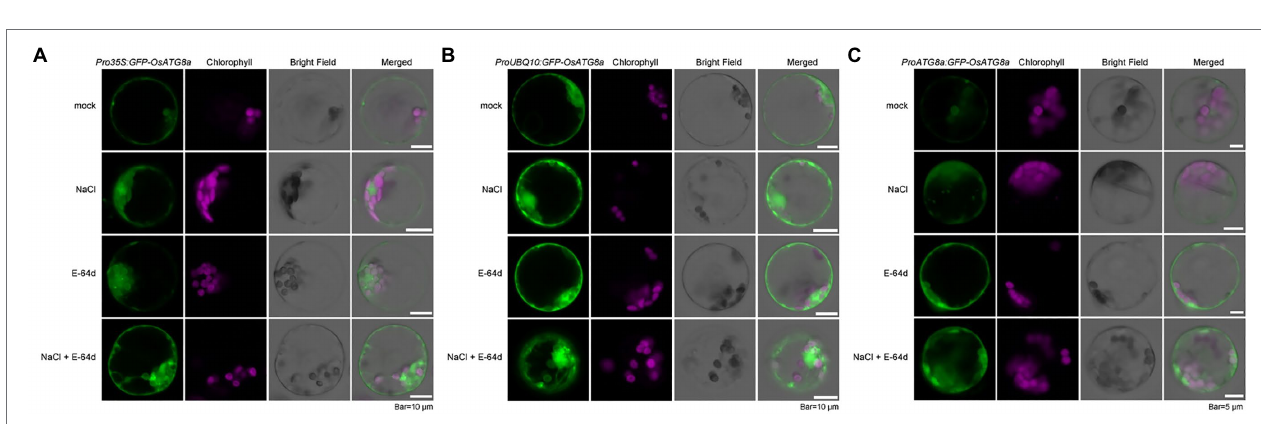
FIGURE 2 | Visualization of autophagic body accumulation in rice protoplasts. Rice protoplasts expressing GFP-OsATG8a driven by (A) 35S promoter, (B) UBQ10 promoter, and (C) OsATG8a promoter were observed with LSCM after treatment with 250 mM NaCl, or 50 μ M E-64d, or NaCl plus E-64d for 30 min. Accumulation of GFP signals, indicative of autophagosome and autophagic bodies, can be seen in protoplasts treated with NaCl plus E-64d. Bar = 10 μ m in (A,B) ; 5 μ m in (C)